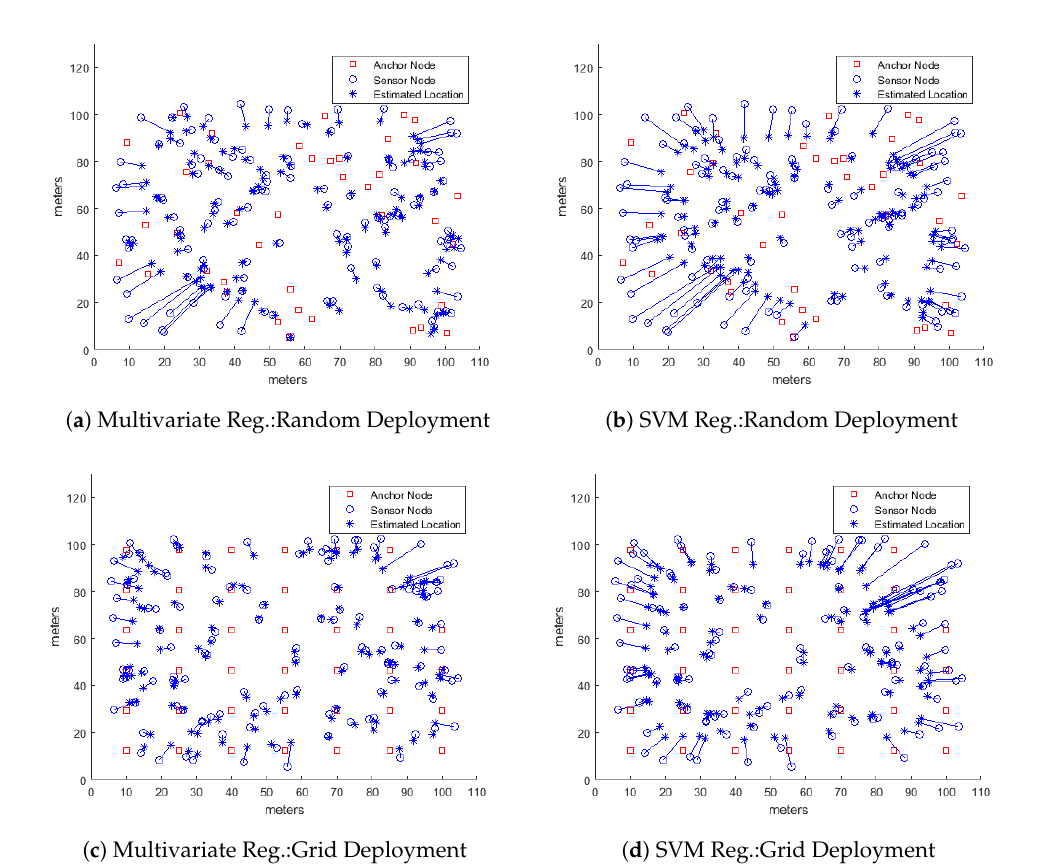
Figure 4. Final layout showing localized nodes in the network using machine learning algorithms when anchor nodes are deployed randomly and in a